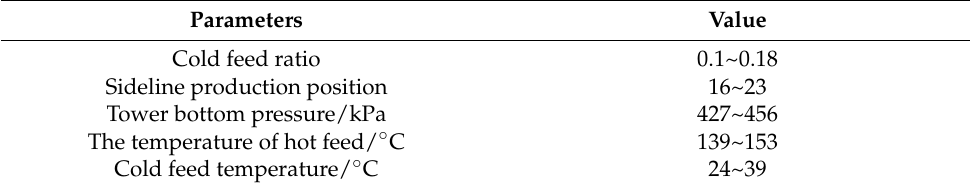
Table 2. Operation